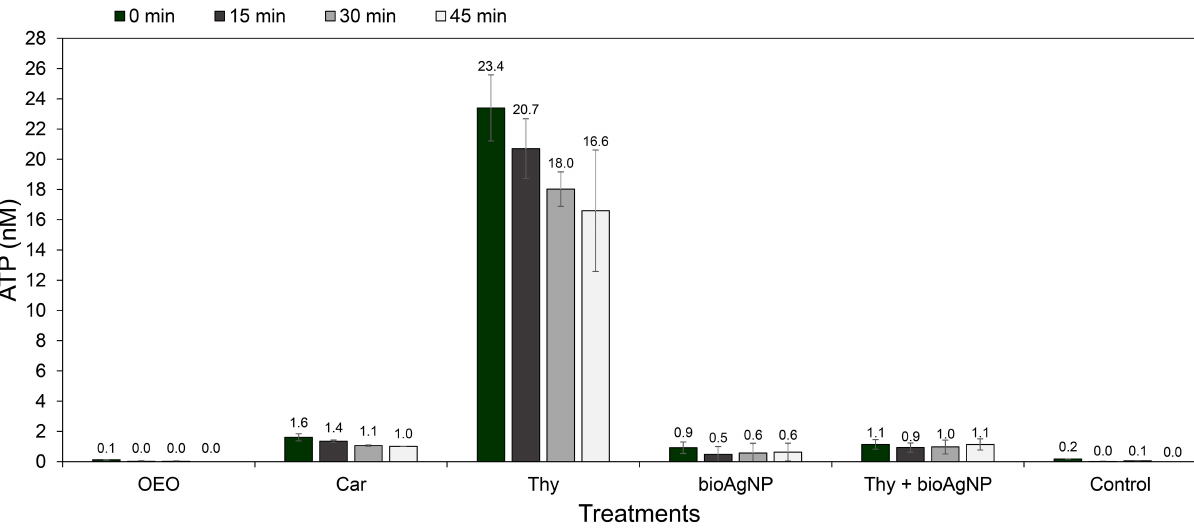
Frontiers in Microbiology |